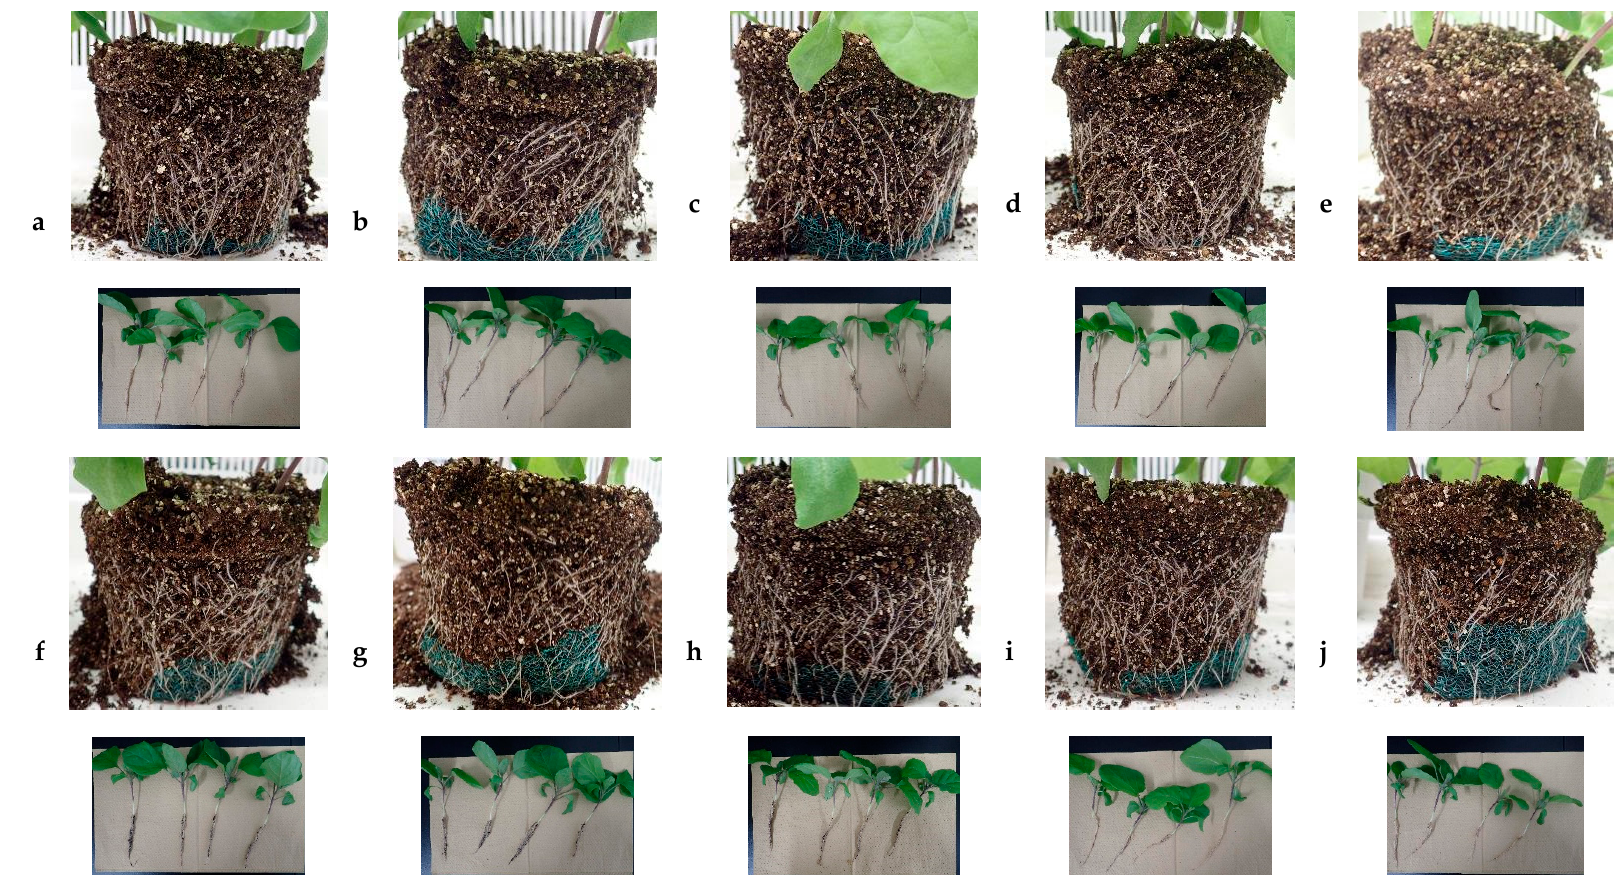
Figure 11. E ff ect of PDJ on eggplant root growth and development. Pictures were taken on the final day (day 28) of pot culture of seedlings treated with 0 ( a and f ), 200 ( b and g ), 400 ( c and h ), 600 ( d and i ), and 1000 ( e and j ) ppm PDJ supplied drip-wise ( a – e ) or by spraying ( f – j ). PDJ at concentrations of 200 and 400 ppm ( b , g and c , h ) resulted in more complex, thicker, and stronger root networks, while PDJ at concentrations of 600 and 1000 ppm ( d , i and e , j ) resulted in less complex, thinner, and weaker root networks. In general, lower concentrations (200–400 ppm) of PDJ applied drip-wise, rather than by spraying, stimulated root growth and development. Drip-wise application of PDJ led to stronger and more robust roots, and better incorporation between soil and roots, while spraying of PDJ led to weaker, fragile roots and a crumbly and brittle (loose) soil